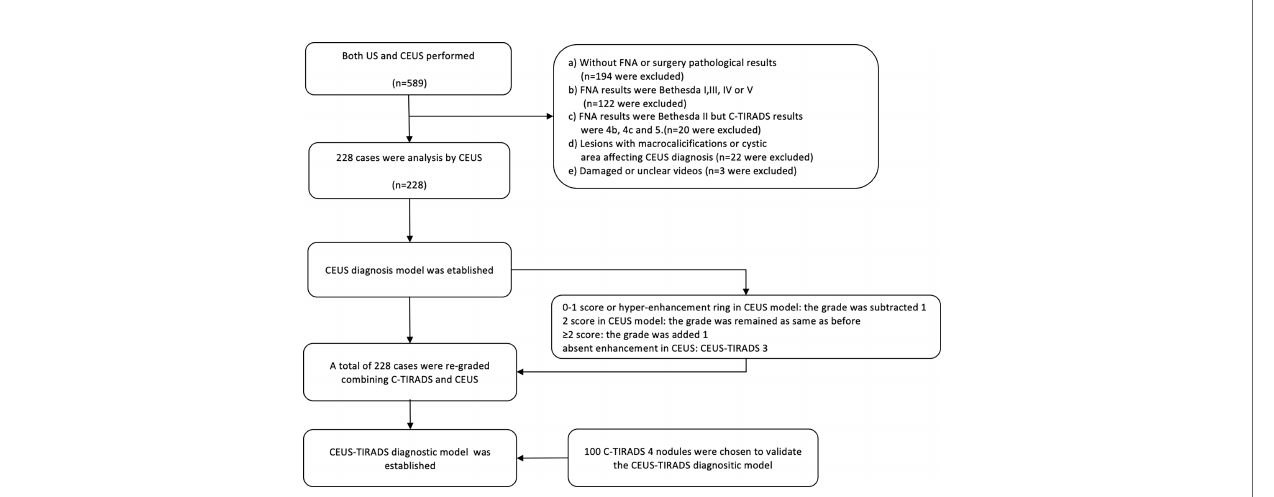
FIGURE 1 | The fl ow chart of the study. FNA, fi ne-needle aspiration; US, ultrasound; CEUS, contrast-enhanced ultrasound; C-TIRADS, Chinese imaging reporting and data